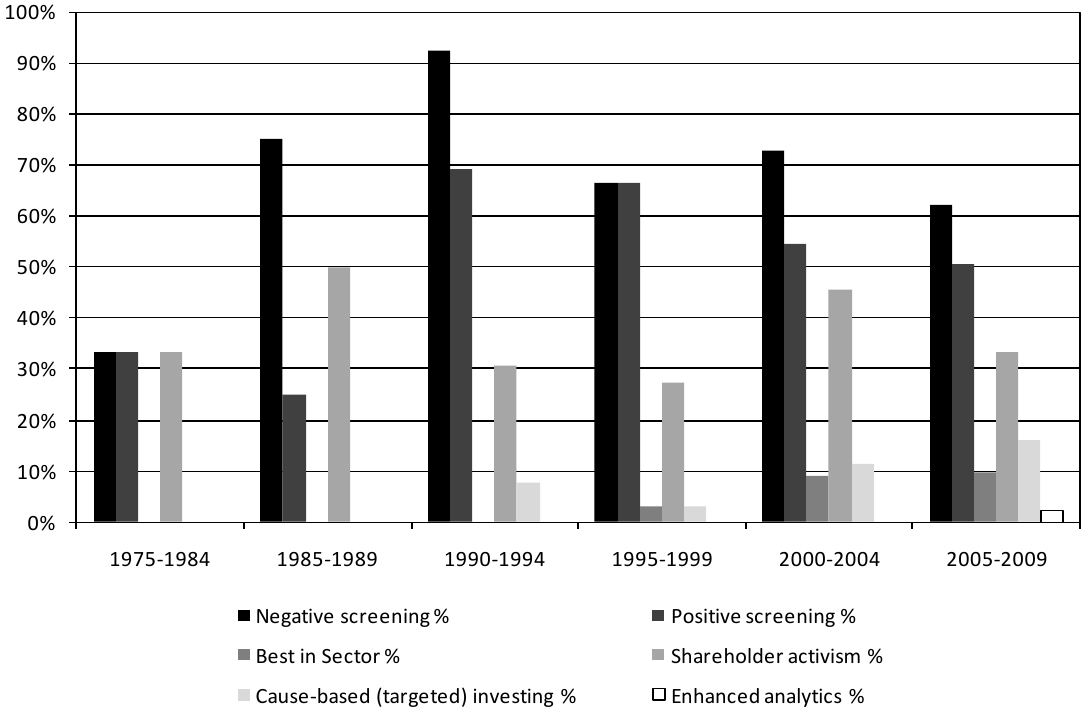
Figure 9: Overall frequency of the occurrence discussions of various SRI strategies in the sample Research Approach : The most commonly observed